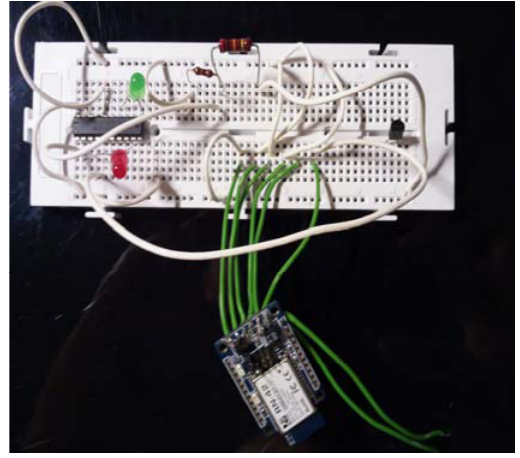
Figure 7. Assembly of the components on the test bed.